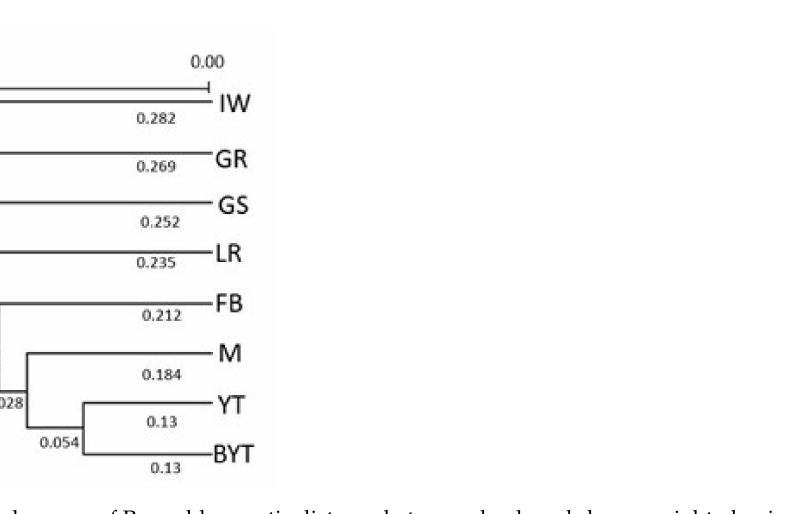
Figure 2. Dendrogram of Reynolds genetic distance between dog breeds by unweighted pair-group method with averages (UPGMA) algorithm.